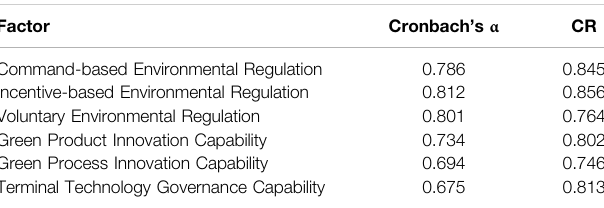
TABLE 2 | Cronbach ’ s α and CR values of each factor.